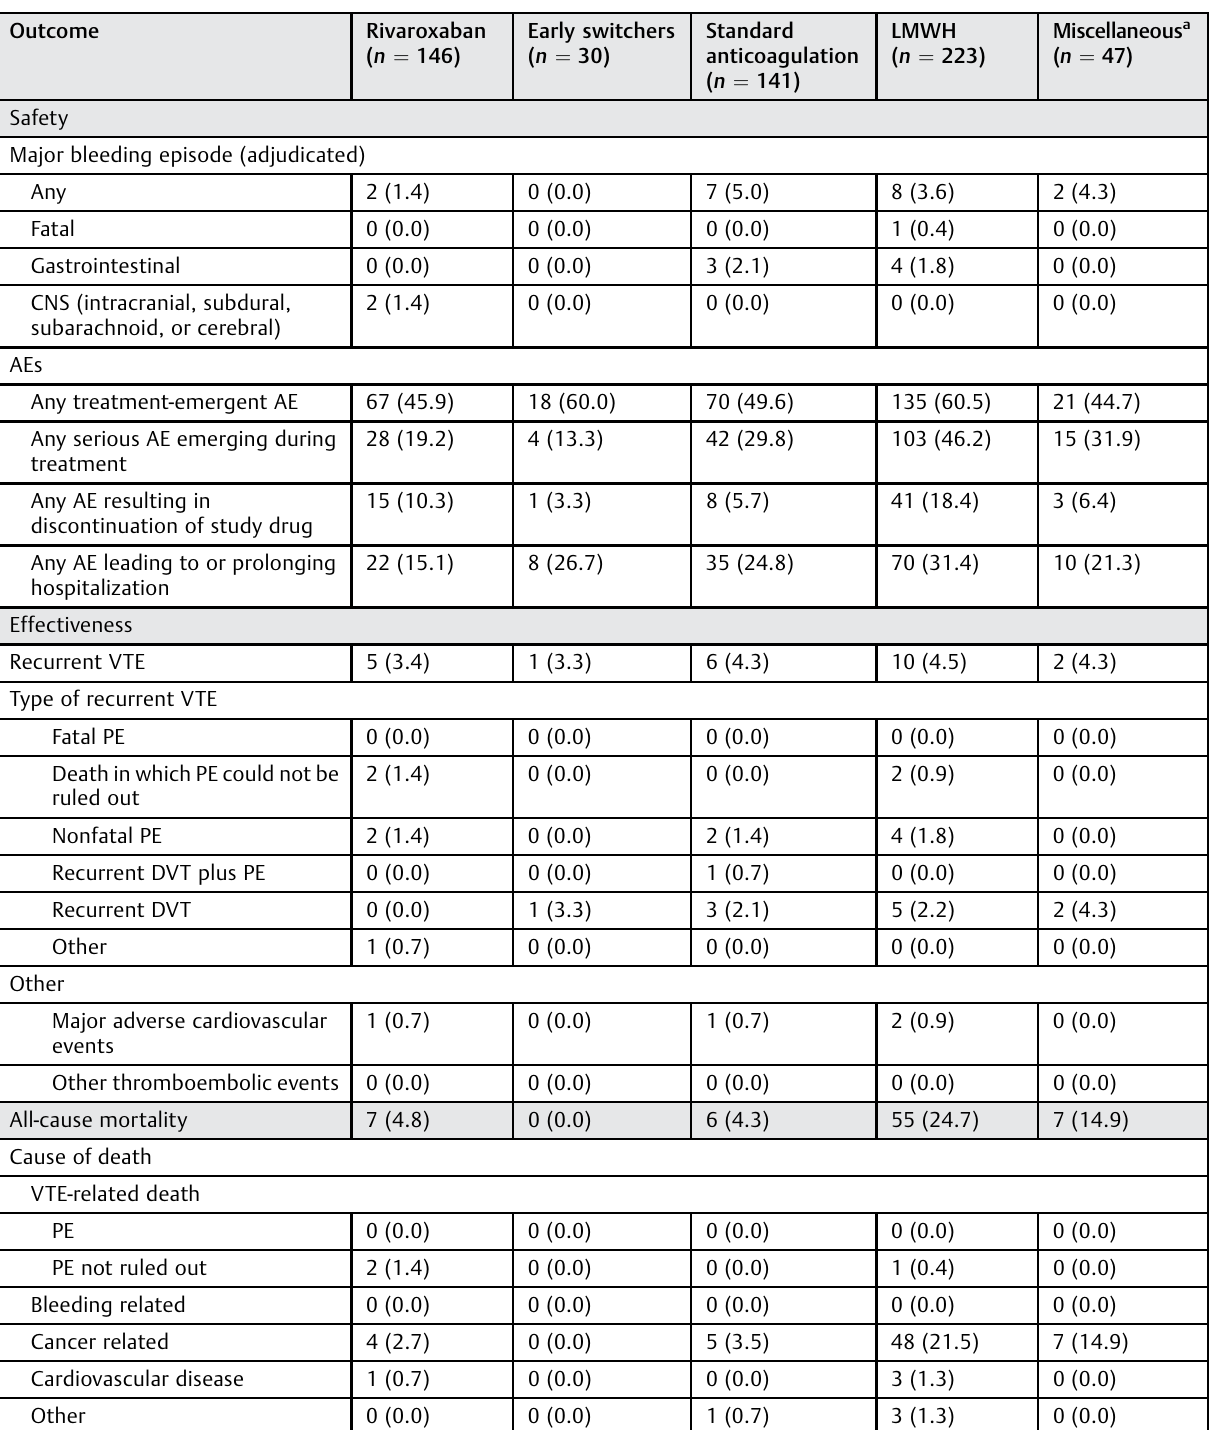
Table 6 Treatment-emergent clinical outcomes in patients with cancer